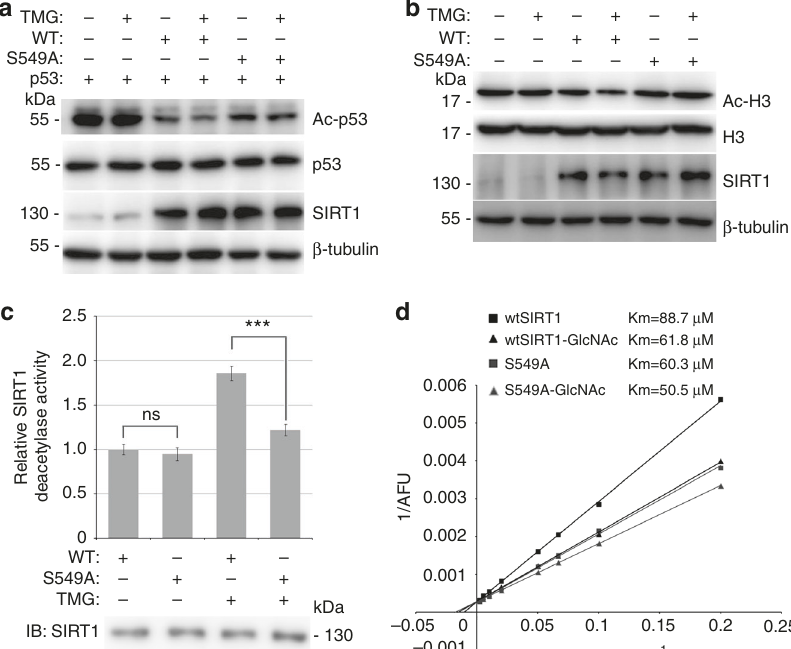
Fig. 4 O-GlcNAcylation of SIRT1 at Ser549 increases its deacetylase activity. a NCI-H1299 cells were cotransfected with p53, shSIRT1 and either Flag- tagged wtSIRT1 or SIRT1 S549A vectors. The cells were then treated by 1 μ M TSA combining with or without 2 μ M TMG for 3 h. The whole-cell extracts were immunoblotted with antibodies against p53 acetylated at Lys 382, p53, or SIRT1. Data represent three independent experiments. b NCI-H1299 cells were cotransfected with shSIRT1 and either Flag-tagged wtSIRT1 or SIRT1 S549A vectors. The cells were then treated by 1 μ M TSA combining with or without 2 μ M TMG for 3 h. The whole-cell extracts were immunoblotted with antibodies against acetylated H3 (Lys 9/14), H3, or SIRT1. Data represent two independent experiments. c NCI-H1299 cells transfected with Flag-tagged wtSIRT1 or SIRT1 S549A were treated with or without 2 μ M TMG for 4 h. SIRT1 was immunopuri fi ed from cell extracts using anti-FLAG M2 Af fi nity Gel, and the relative deacetylase activity was determined in vitro at the concentration of 25 μ M fl uorogenic acetylated p53 peptide substrate and 500 μ M NAD + using a fl uorometric assay system. Data represent two independent experiments. d The enzyme kinetic parameters were detected by varying the p53 (K382Ac) fl uorometric peptide substrate concentration while keeping NAD + at a saturating concentration for wtSIRT1 (black square), wtSIRT1 bearing O-GlcNAc (wtSIRT1-GlcNAc) (black triangle), SIRT1 S549A (gray square),